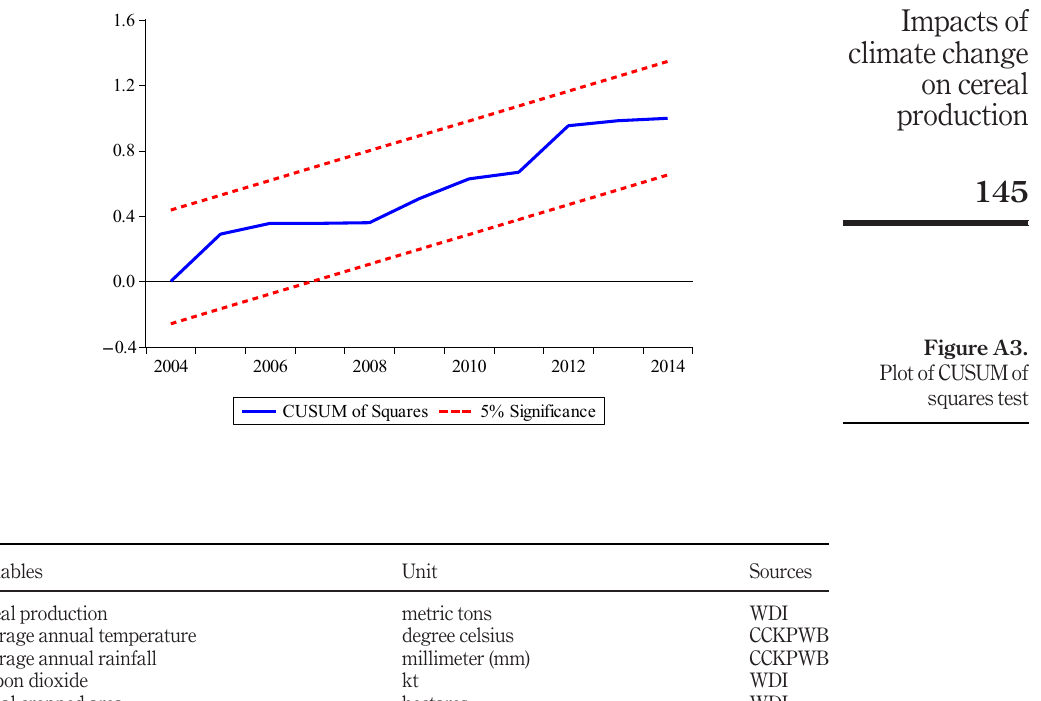
Table A1. Description of the selected study